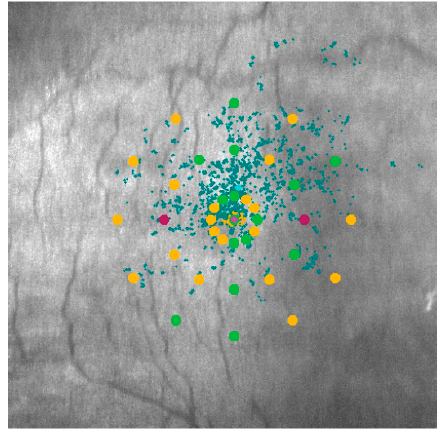
Figure 1. Microperimetry corresponding to a mild cognitive impairment (MCI) subject. The circles in green, yellow, and purple are the 37 measurement points in which retinal sensitivity is assessed. Different colors indicate different retinal sensitivity at each point (green being the best and purple the worst). The blue dots are the fixation points detected during the whole examination (3.5 min).